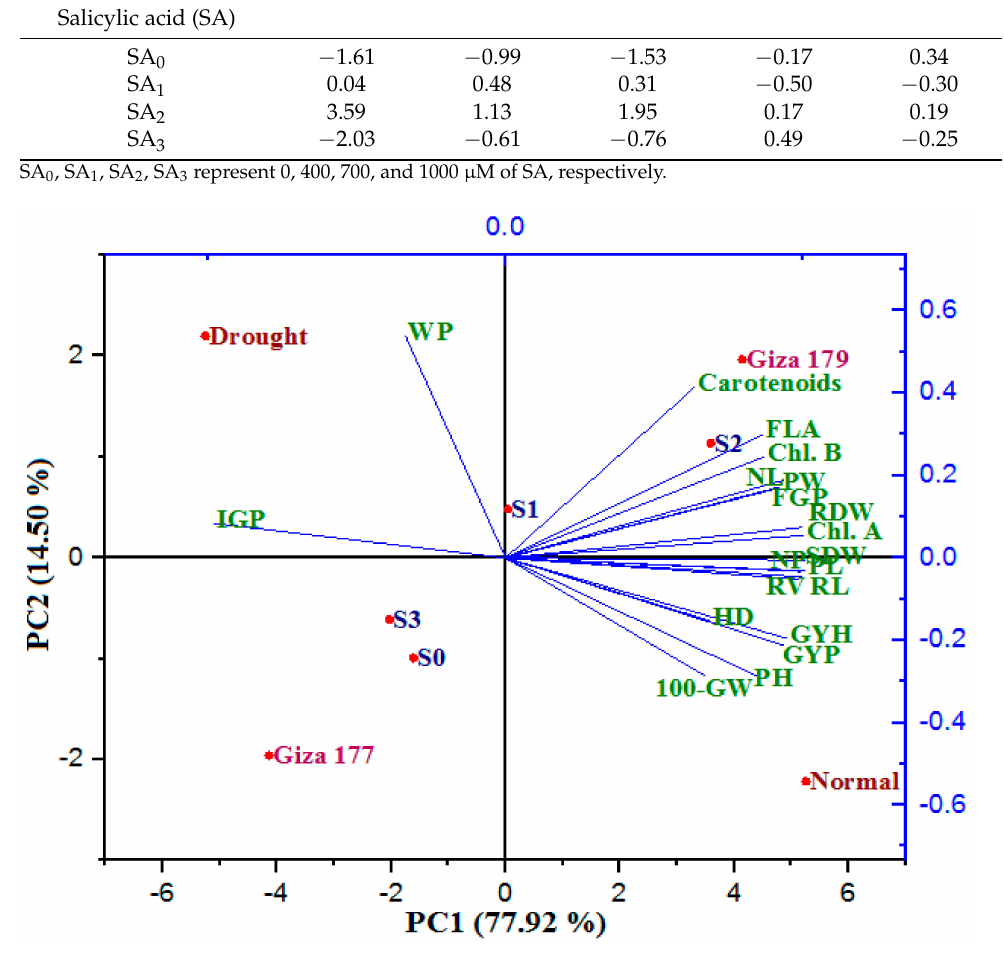
Figure 5. A biplot diagram based on principal component analyses (PC1) and PC2 shows similarity and dissimilarity relationships among the measured traits across two Egyptian rice cultivars and different salicylic acid (SA) concentrations under normal and drought stress conditions. S0, S1, S2, and S3 represent 0, 400, 700, and 1000 µ M of salicylic acid, respectively. RL: root length (cm); PH: